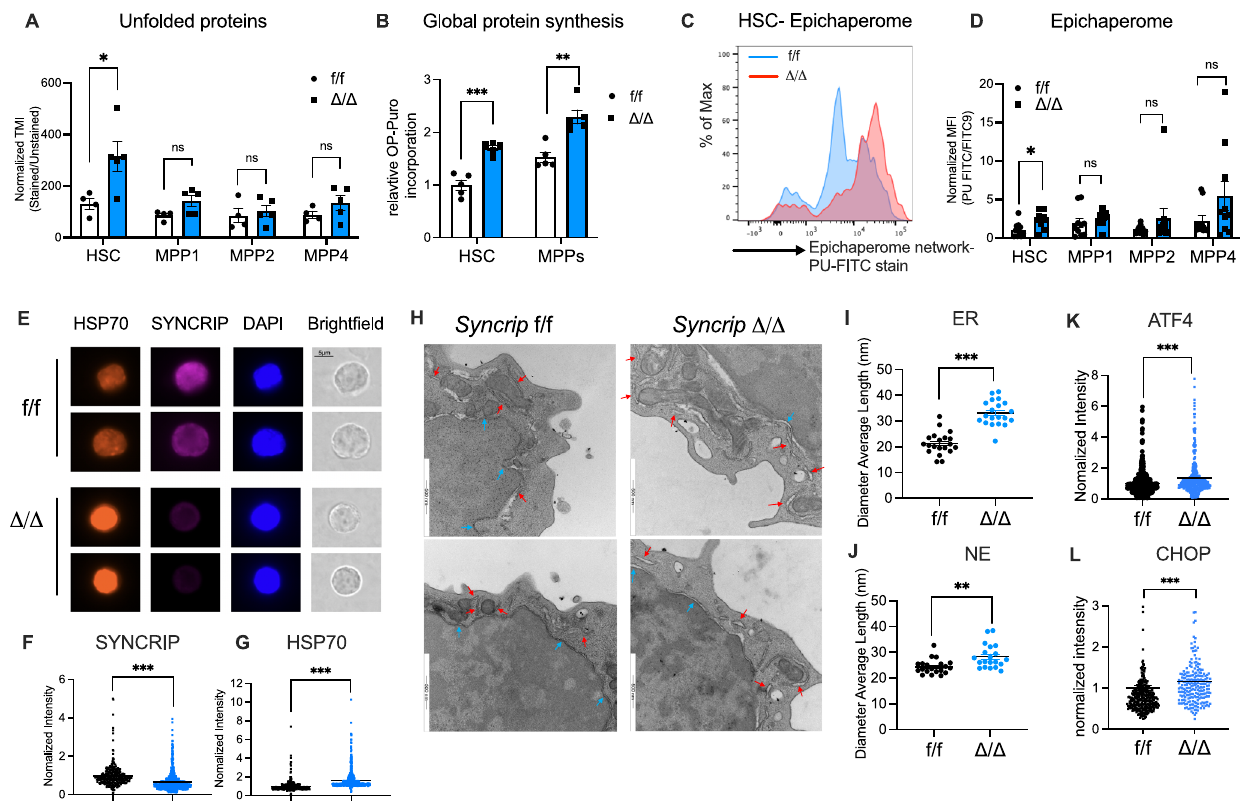
Fig. 4 | Deletion of SYNCRIP deregulates the proteostasis network in HSCs. A Quantitativesummaryofrelativetetraphenylethenemaleimide(TMI) fl uorescent signals in HSC, MPP1, MPP2 and MPP4. TMI signals were used to quantify the unfolded proteins in single hematopoietic cells in Syncrip f/f ( n =4) vs. Syncrip Δ / Δ ( n =5). B OP-Puro incorporation in HSC ( p =0.00017) and MPP ( p =0.0017) populations isolated from Syncrip f/f ( n =5) vs. Syncrip Δ / Δ ( n =5) 1st transplant reci- pient mice. OP-Puro incorporation was used to quantify the level of global protein synthesis in single hematopoietic cells. C Representative histograms of PU-FITC fl ow analysis of HSCs from Syncrip f/f vs. Syncrip Δ / Δ . D Quantitative summary of PU- FITC fl uorescent signals normalized to FITC control in HSC p =0.0123, MPP1 p =0.32, MPP2 p =0.27 and MPP4 p =0.12. PU-FITC signals were used to quantify the epichaperome signal of hematopoietic cells in Syncrip f/f ( n =10) vs. Syncrip Δ / Δ ( n =10). E Immuno fl uorescence(IF)stainingofHSP70andSYNCRIPin Syncrip f/f and Syncrip Δ / Δ HSCs(showninbright fi eld).Scalebar5 μ m. F , G Quantitativesummaryof